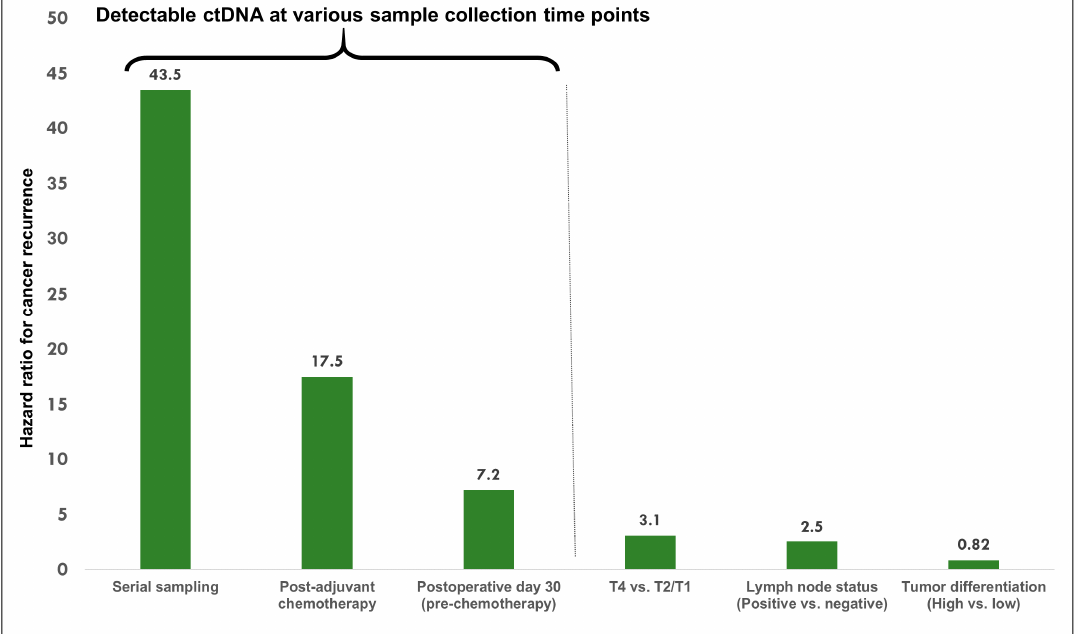
Figure 2. Hazard ratio (HR) for cancer recurrence with ctDNA detectable at various time points after surgery (postoperative day 30, post-adjuvant chemotherapy and serial samplings during surveillance) [7] in patients with early-stage colon cancer in comparison to other clinicopathologic risk factors-tumor extent (T4 vs. T2/T1), regional lymph node involvement status and tumor differentiation [51].